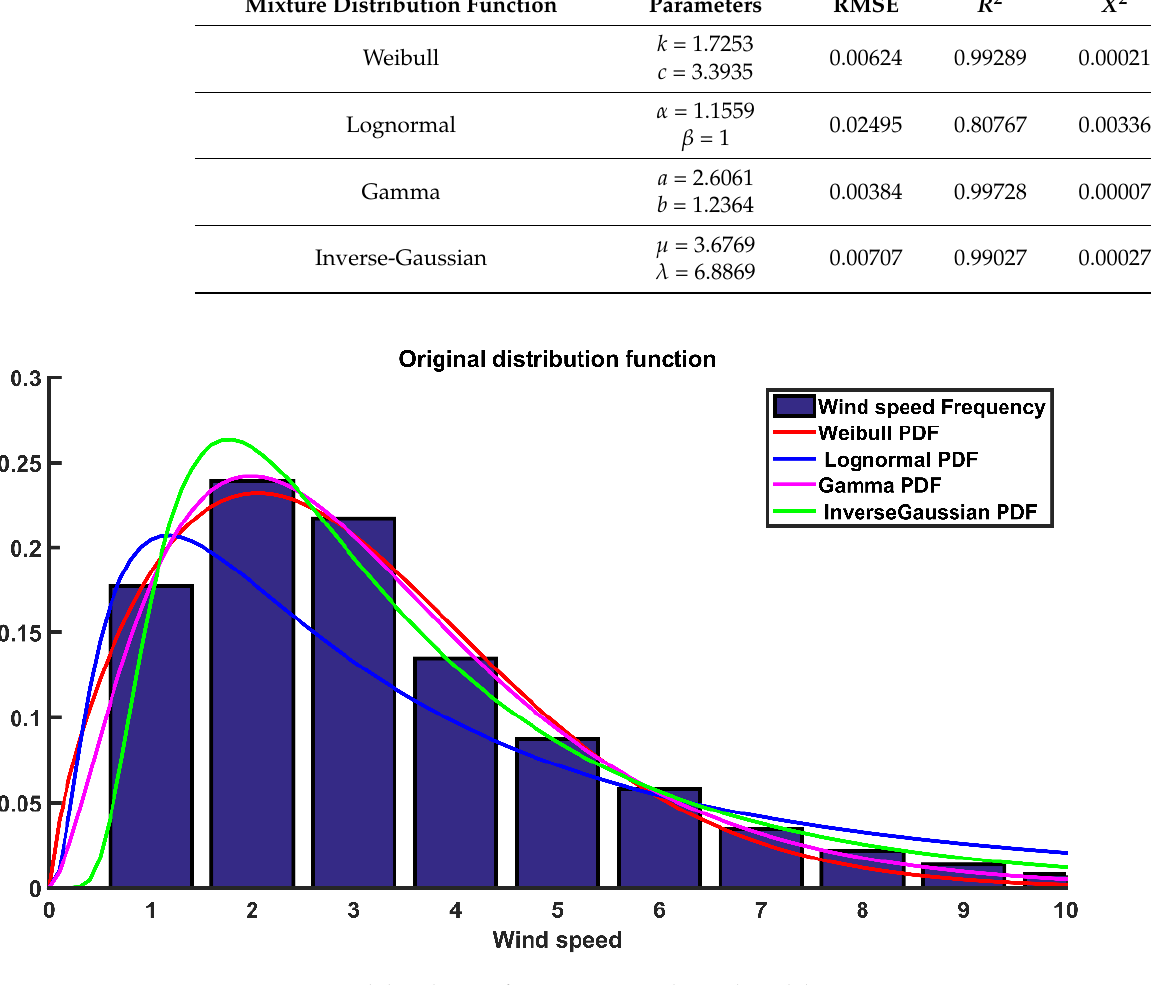
8 of 16 Figure 1. Flowchart of the Mayfly algorithm.